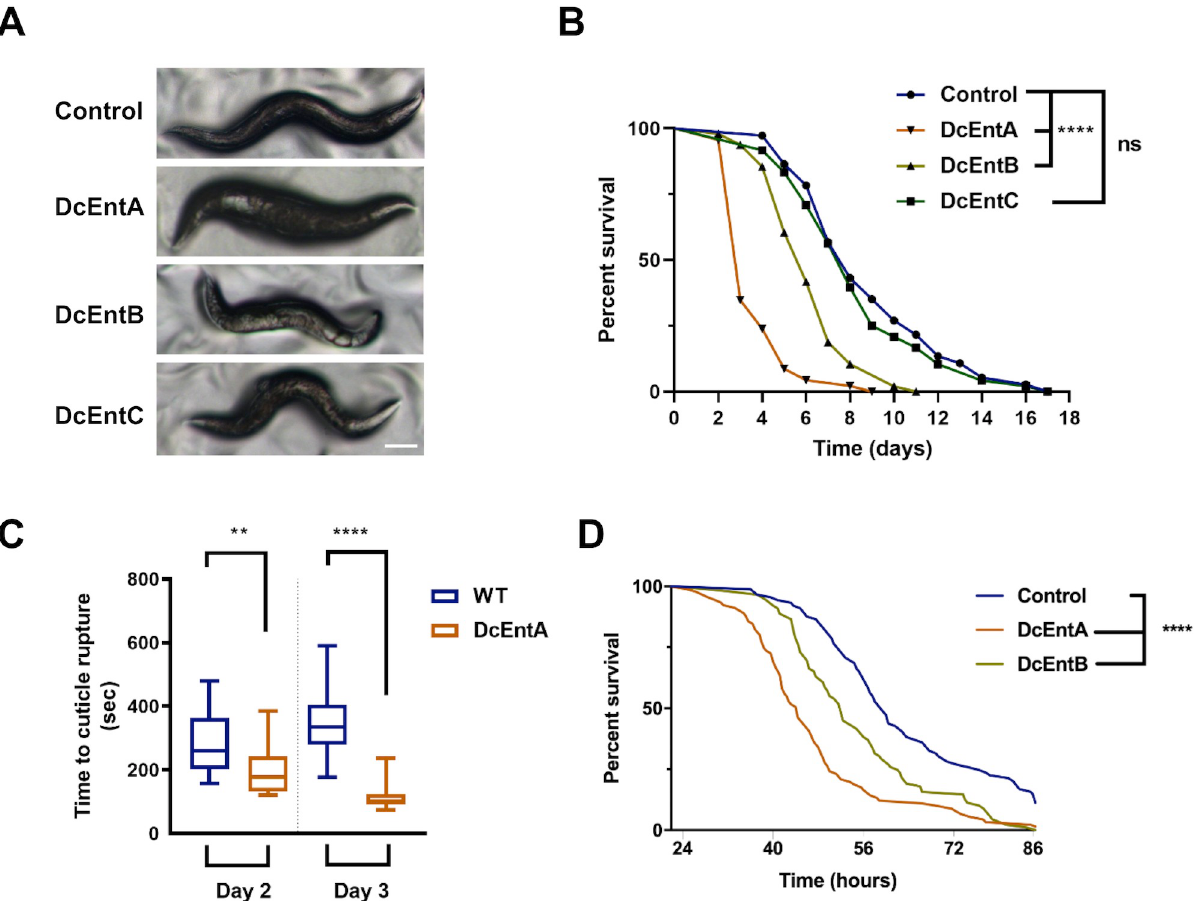
Fig 2. Expression of DcEntA or DcEntB makes worms sick and die precociously. ( A ) Representative images of control and enterotoxin-expressing worms on the third day of adulthood. From the top: control, DcEntA-, DcEntB- and DcEntC-expressing worms (JDW141, IG1926, IG1925 and IG1880, respectively); scale bar, 100 μ m. ( B ) Lifespan counted from the L4 stage at 25˚C of worms of these 4 strains. For each strain, n = 50. ���� p < 0.0001, one-sided log rank test. ( C ) Expression of DcEntA increases cuticle fragility in 2- and 3-day old adult worms. Tukey boxplots (n > 20, for each condition); unpaired t test, �� p < 0.01; ���� p < 0.0001. ( D ) Survival of worms carrying frIs7 [ nlp-29p :: GFP and col-12p :: dsRed ] and a hygR transgene (control; IG1864) or also expressing DcEntA (IG1942) or DcEntB (IG1941) after infection as young adults with D . coniospora at 25˚C (n = 91, 89 and 89 respectively). ���� p < 0.0001, one-sided log rank test. Representative of 3 independent biological